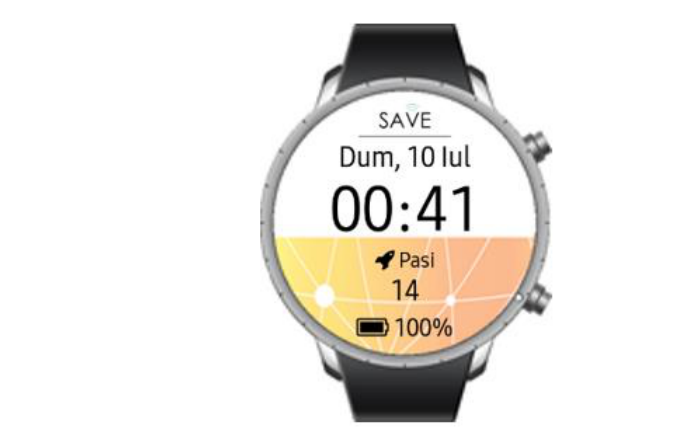
Figure 6. SAVE configuration app.